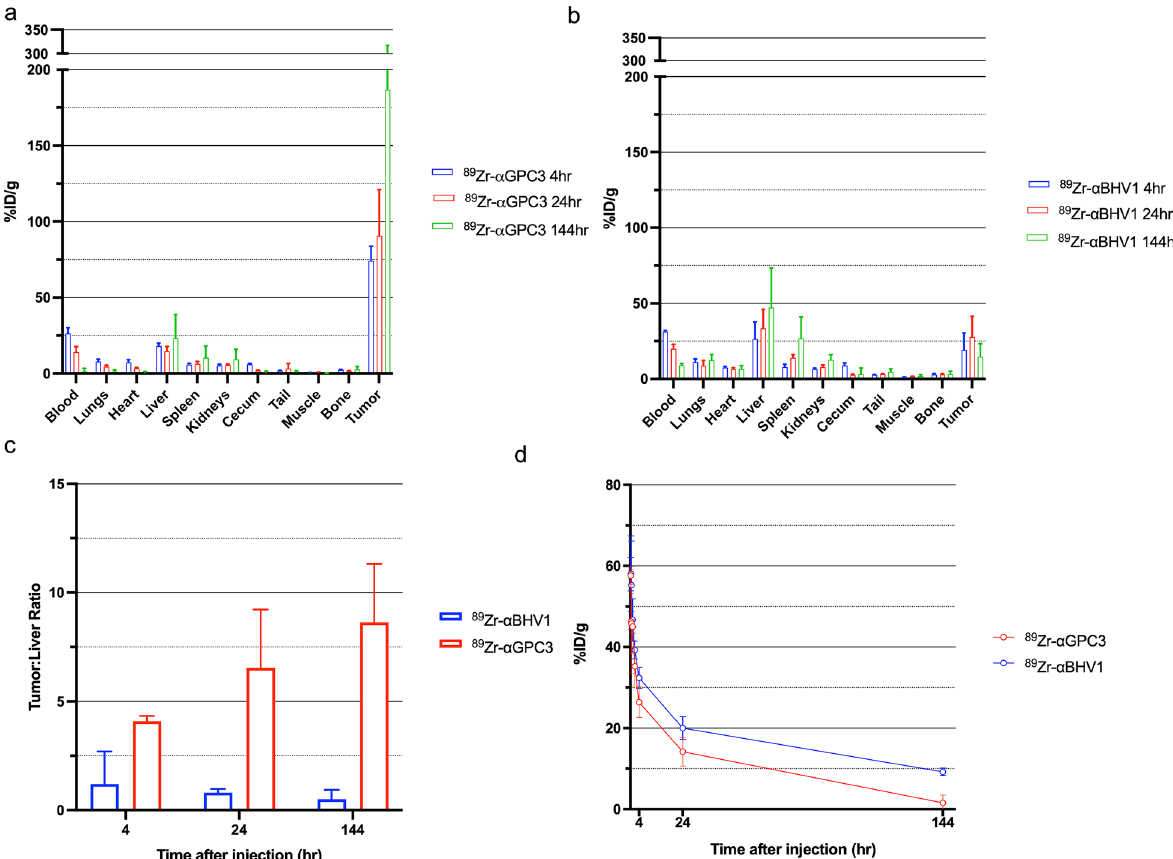
Fig. 1 89 Zr-aGPC3 avidly binds to tumor with minimal off-target binding. a , b Tissue biodistribution of 89 Zr-aGPC3 and 89 Zr-aBHV1 in tumor-bearing mice 4 h (n 4), 24 h (n 4), and 144 h ( n 3 for GPC3, n 6 for BHV1) after injection. c Tumor-to-liver ratio 4 h, 24 h, and 144 h after injection. d = = = = Comparative blood clearance profiles in tumor-bearing mice at 5, 15, 30, 60, 120, 240 min, 24 h and 7 days after injection with of 89 Zr-aGPC3 or 89 Zr-aBHV1 (n 4/time point). Bar and symbol denote mean, error bar denotes standard =